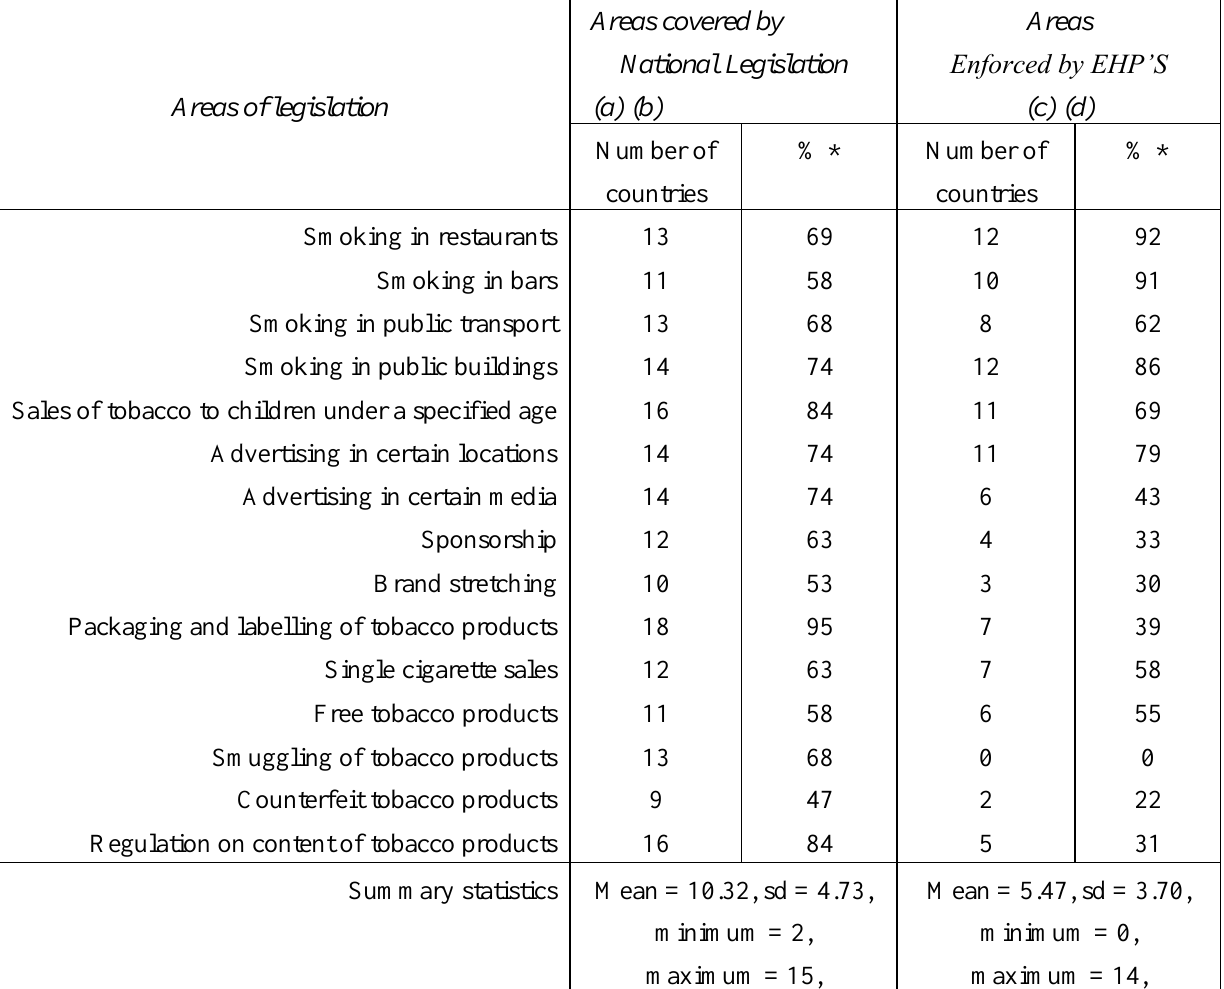
Table 2. Areas Covered by National Tobacco Legislation and EHP‟s